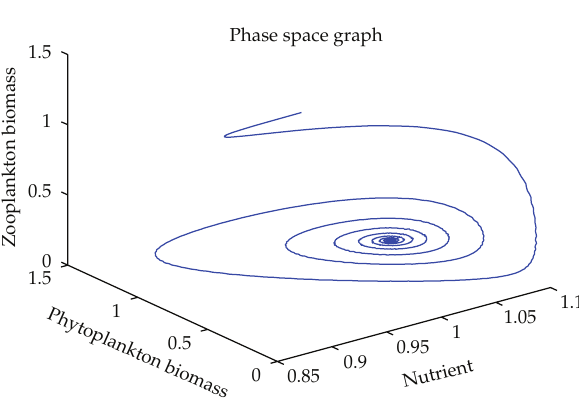
Figure 1: Phase-space diagram for nutrient, phytoplankton, and zooplankton at α (cid:7) 1 . 1.